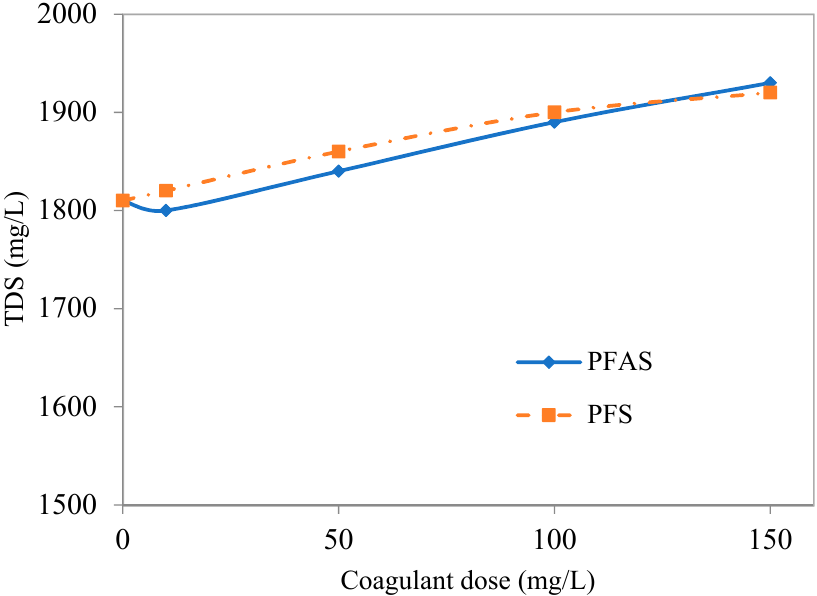
Figure 5. Total dissolved solids as a function of coagulant dose during treatment of brewery wastewater .